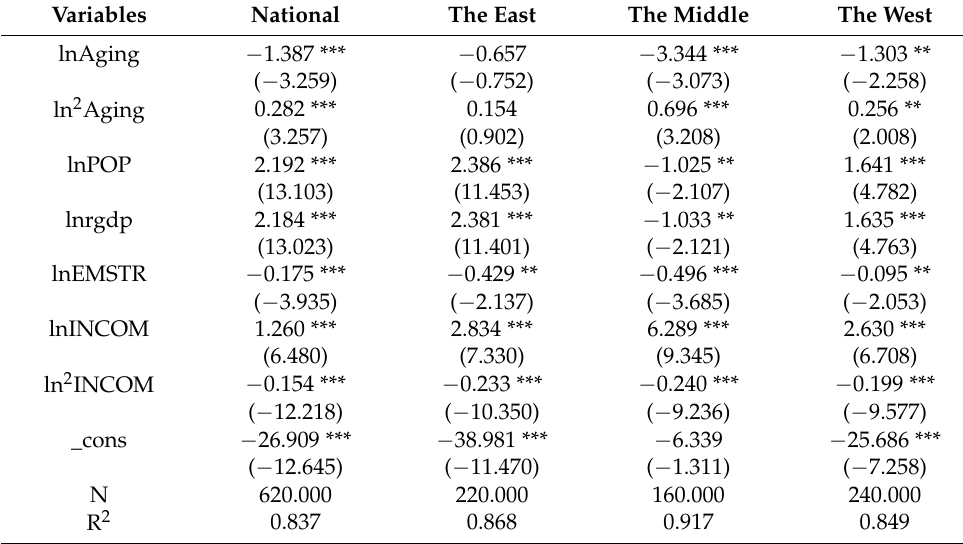
Table 4. The impact of population aging on carbon